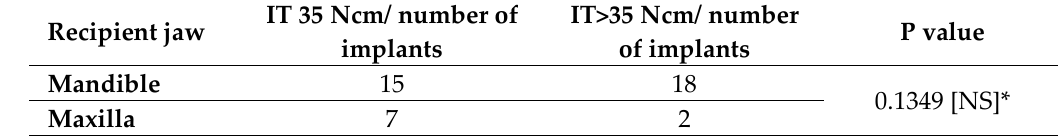
Table (5): The differences of the IT in relation to the recipient